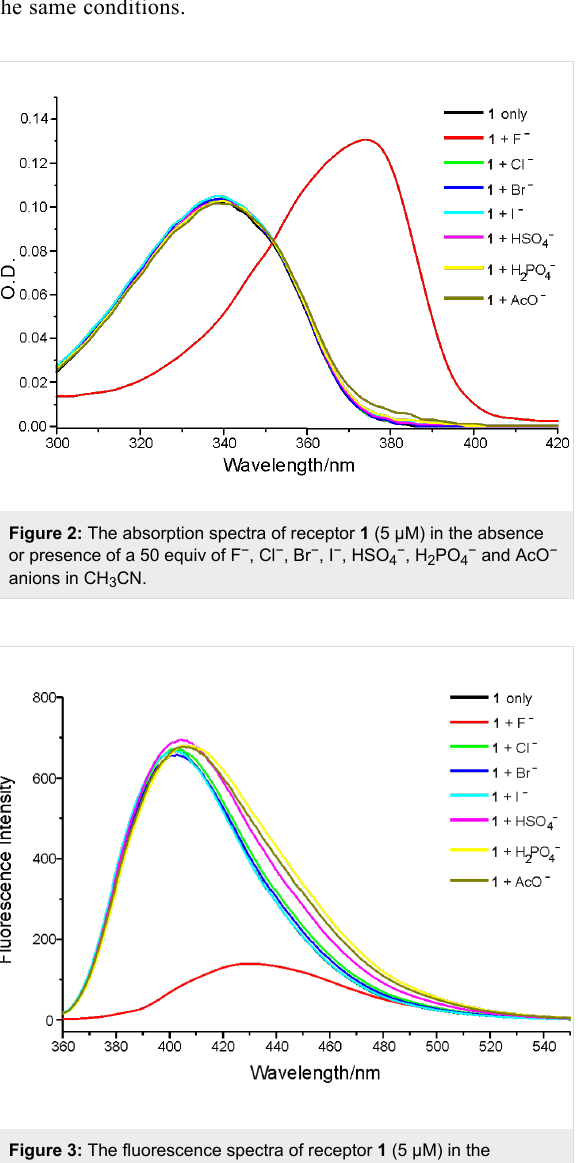
Figure 1: (a) Receptor 1 . (b) ORTEP drawing of receptor 1. Thermal ellipsoids are drawn at the 30% probability level.